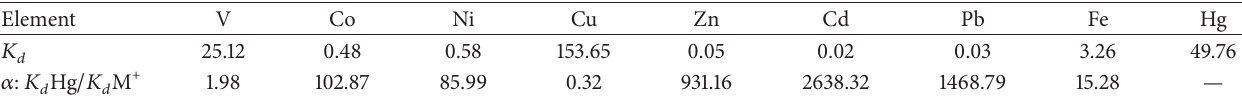
Table 4: Metal distribution coefficient (𝐾 𝑑 ) and separation factor (𝛼) at pH 4 in multielement